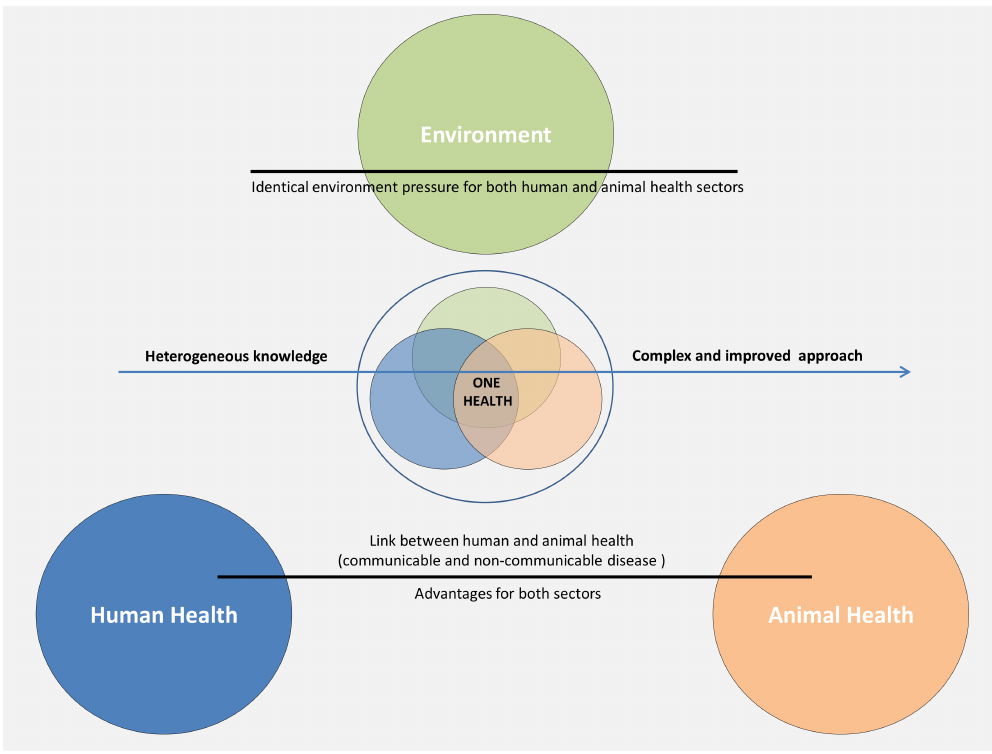
Figure4. Theconcept of“OneHealth” appliedto cancerstudies.Although thisconceptis mainlyapplied to communicable disease a ff ecting both humans and animals under a similar environment, the same strategy should be translated to the oncology sector due to similarities in the clinical characteristics and pathological evolution under the pressure of the same general